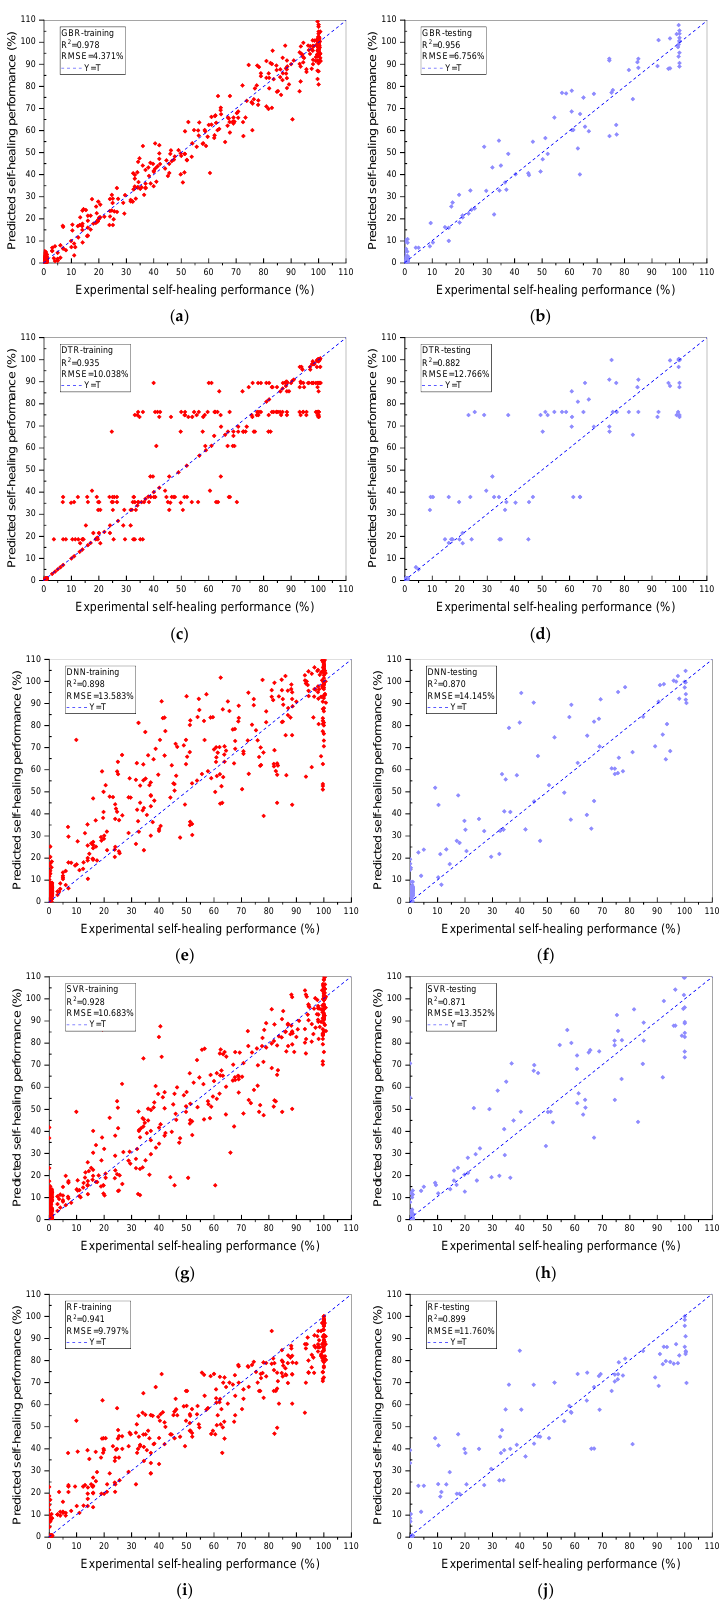
Figure 2. Experimental vs. predicted HP for the models: ( a ) GBR-training; ( b ) GBR-testing; ( c ) DTR- training; ( d ) DTR-testing; ( e ) DNN-training; ( f ) DNN-testing; ( g ) SVR-training; ( h ) SVR-testing; ( i ) RF-training; and ( j ) RF-testing, with the corresponding R 2 and RMSE.